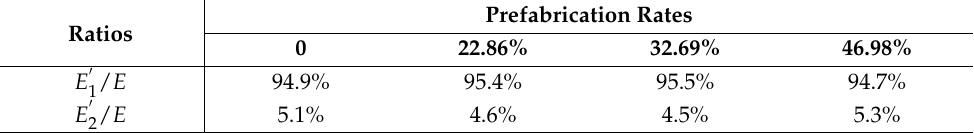
Table 11. Carbon Emission Ratios under Different Prefabrication Rates.